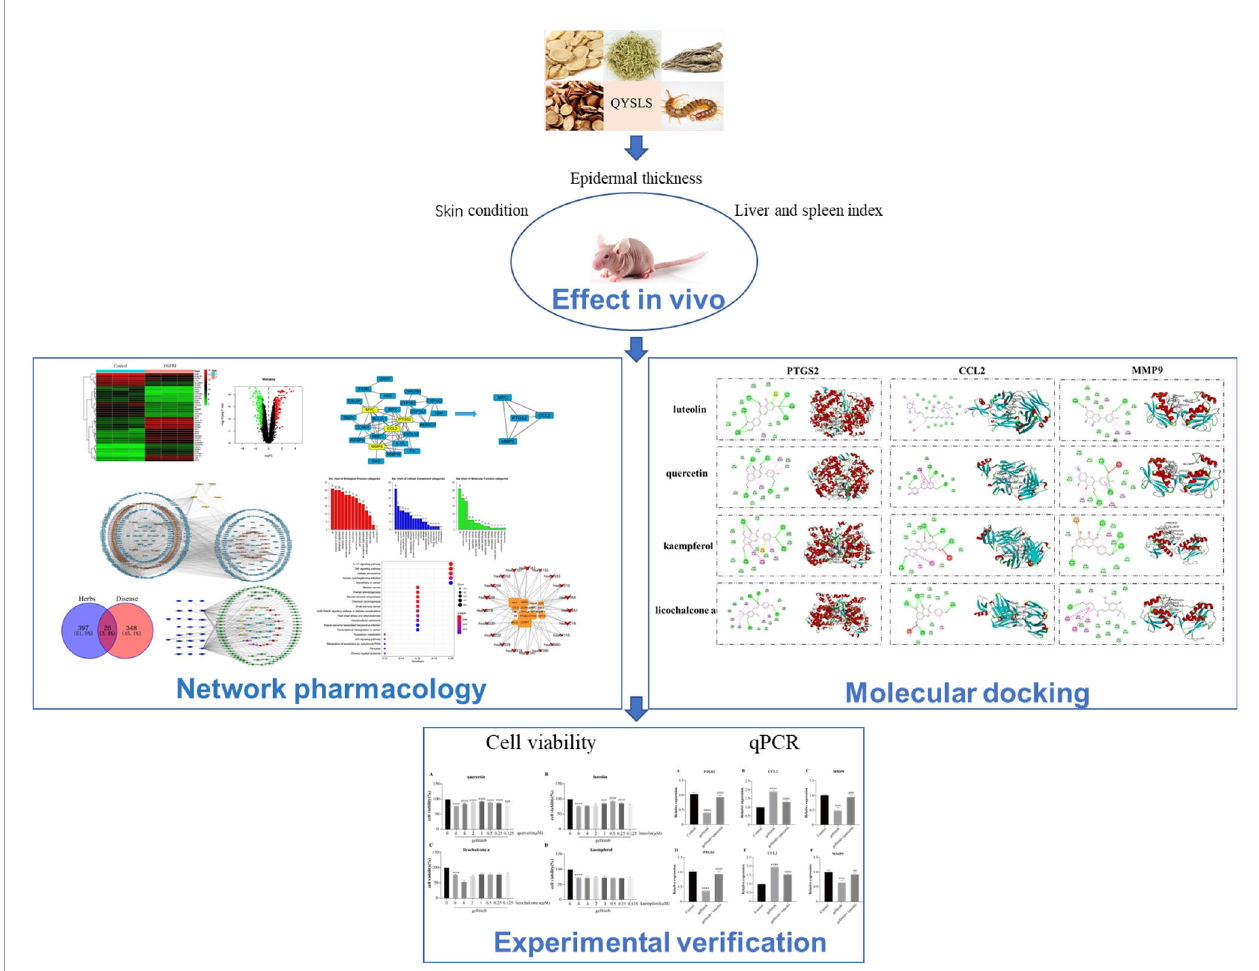
FIGURE 1 | Flowchart of the network pharmacology and experimental study of QYSLS in the treatment of adverse skin reactions caused by EGFR